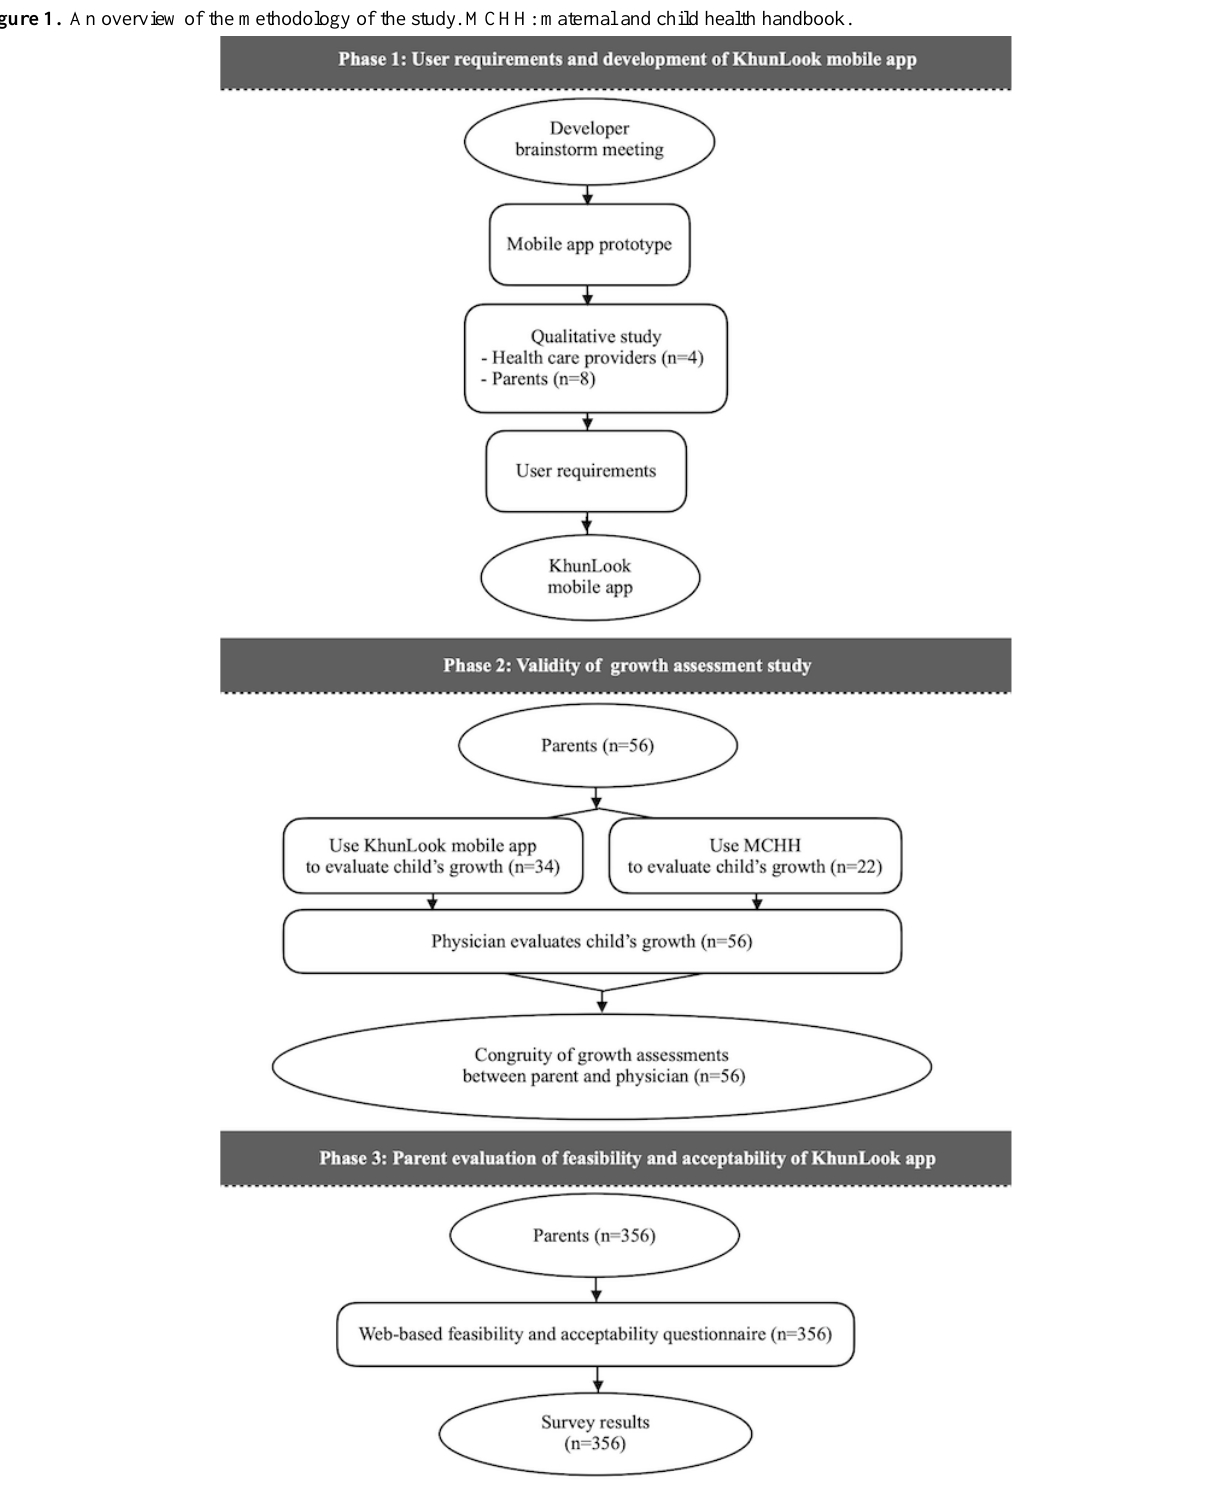
Figure 1. An overview of the methodology of the study. MCHH: maternal and child health